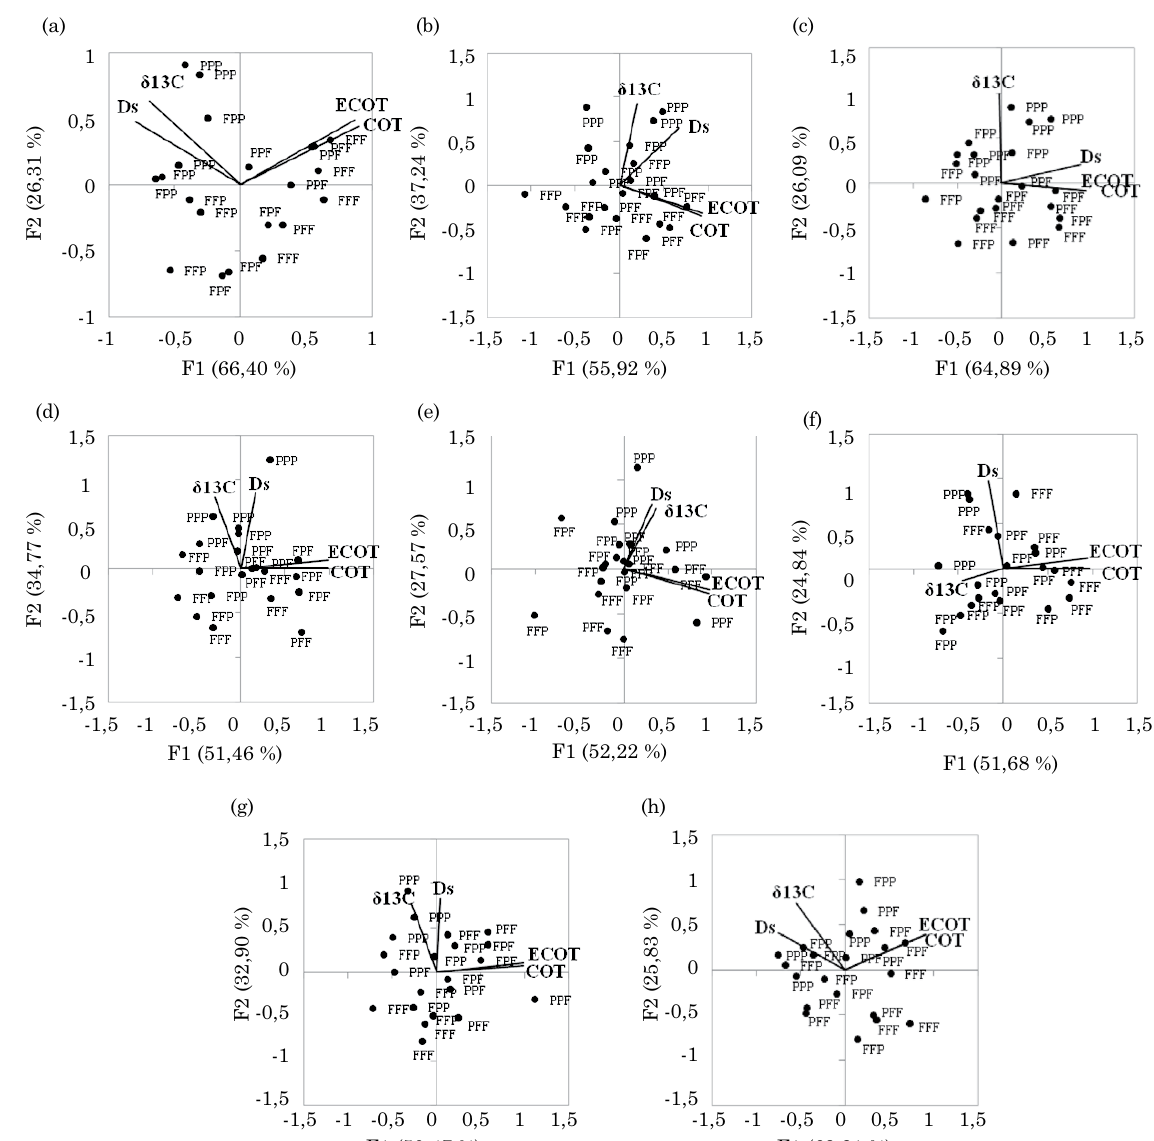
Figura 8. Gráfico biplot bidimensional da ACP para carbono orgânico total (Cot), estoque de carbono (ECot), densidade do solo (Ds) e abundância isotópica de 13 C (δ 13 C). F1 (componente principal 1) e F2 (componente principal 2). Nas camadas 0,00-0,10 m (a), 0,10-0,20 m (b), 0,20-0,30 m (c), 0,30-0,40 m (d), 0,40-0,50 m (e), 0,50-0,60 m (f), 0,60-0,80 m (g) e 0,80-1,00 m (h), para os tratamentos FFF, PFF, FPF, FFP, PPF, FPP e PPP. FFF: uso com floresta a mais de 70 anos; FPF: área ocupada nos últimos 25 anos por floresta, antecedida por um período de 25 anos por pastagem e anteriormente por floresta; PFF: uso com florestas nos últimos 50 anos e pastagem no período anterior a 1957; PPF: área ocupada nos últimos 25 anos com floresta, antecedida por pastagem; PPP: uso com pastagem a mais de 70 anos; FFP: uso com pastagem nos últimos 25 anos; e FPP: uso com pastagem nos últimos 25